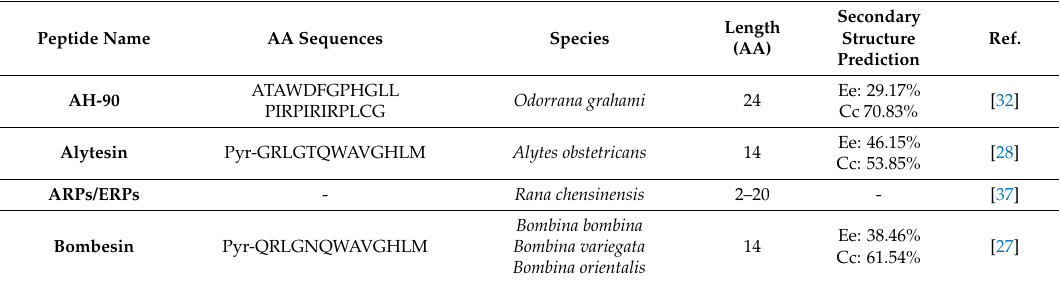
Table 1. Wound healing peptides relevant for amphibian skin defense. Secondary structure prediction was performed by GOR IV algorithm